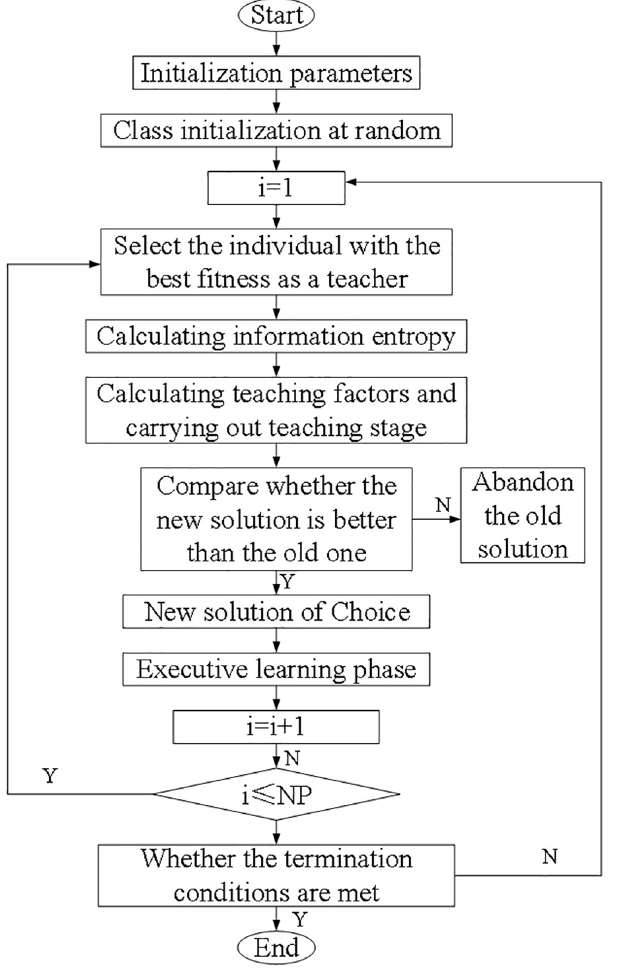
Fig 3. MTLBO algorithm